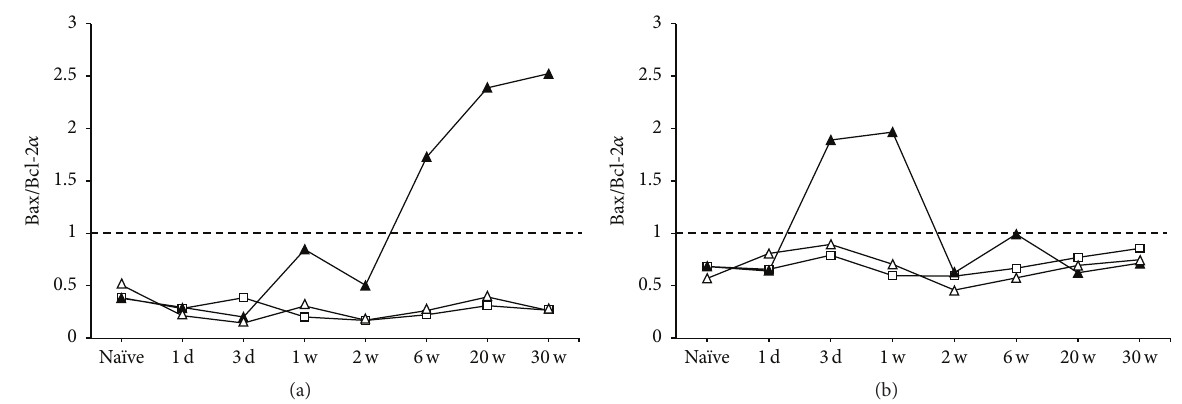
Figure10:TimecoursechangesofBax/Bcl-2 𝛼 indexinGCL(a)andSGZ(b).Symbolsusedareasfollows:opensquare,sham;closedtriangles, ipsilateral MCAO; open triangles, contralateral